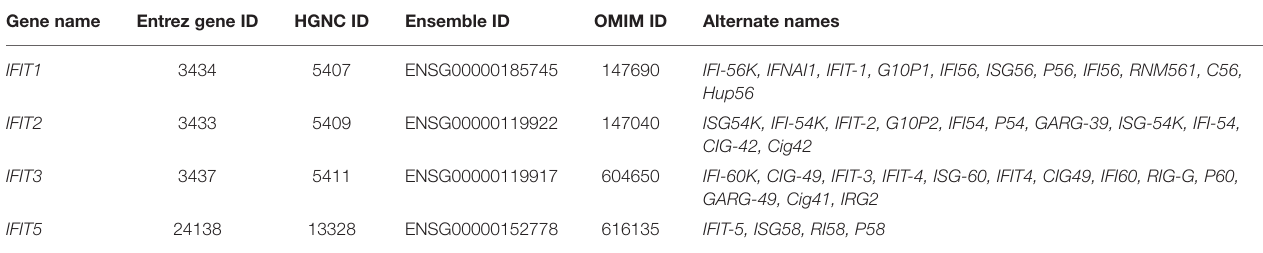
TABLE 1 | Synopsis of all available gene database information and synonyms for Human IFIT